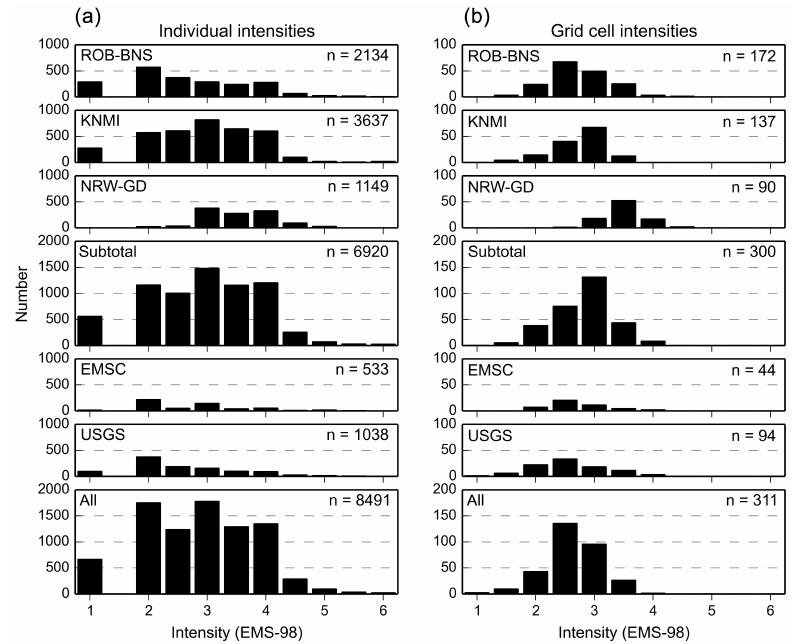
Figure 5. Goch earthquake intensity distributions binned per half-intensity units. Left: intensity distribution of the (geocoded, if possible) IDPs. NRW-GD lacks intensity I or “not-felt” entries. Right: grid cell intensity distributions of cells with at least three responses. The sum of responses submitted to the national institutes is far larger than the sum of those arriving at international